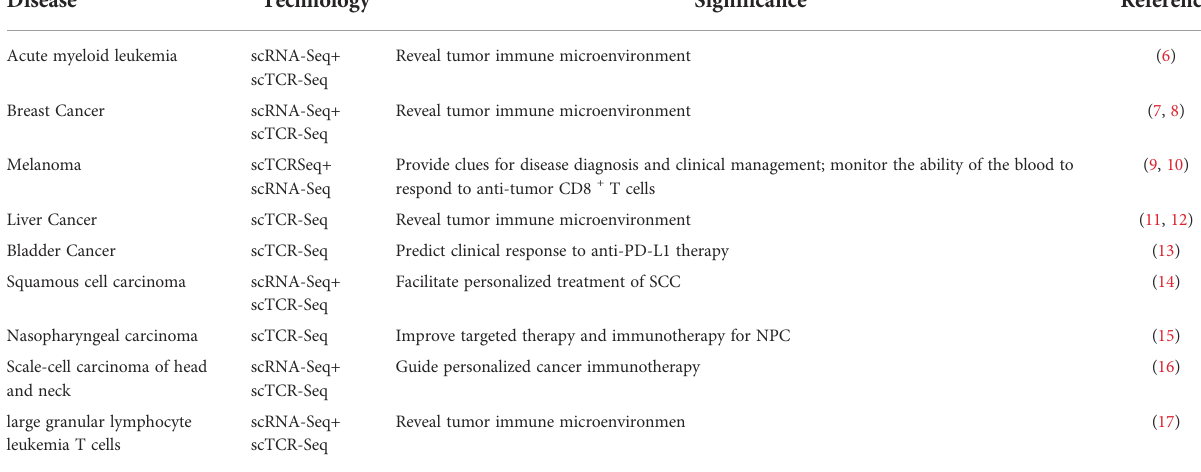
TABLE 1 Summary of the application of single-cell TCR/BCR sequencing technology in tumor